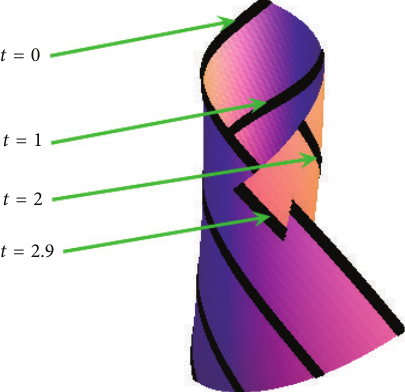
= 0.8 , and 𝑐 = 0.5 . 1 2